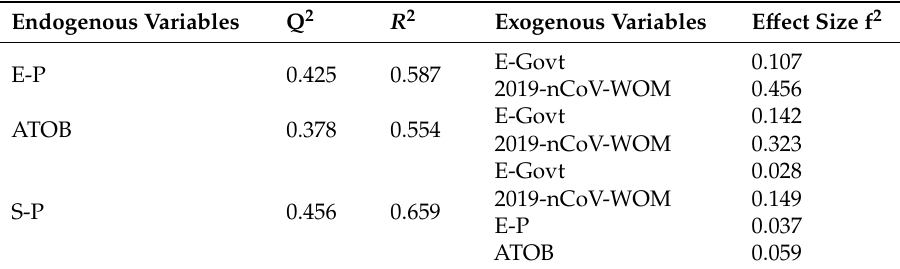
Table 6. E ff ect size and predictive